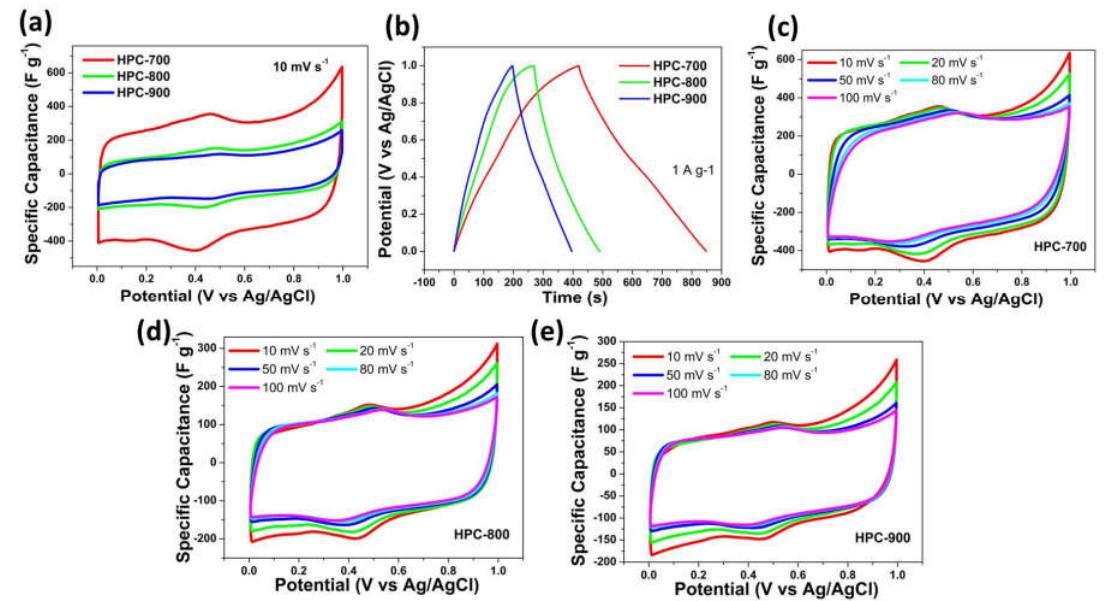
Figure 6. ( a ) CV curves at 10 mV s −1 and ( b ) GCD curves at 1.0 A g −1 of HPC-700, HPC-800, and Table 3. Specific capacitance of HPC-700 and some biomass-derived porous carbon reported in the literature.